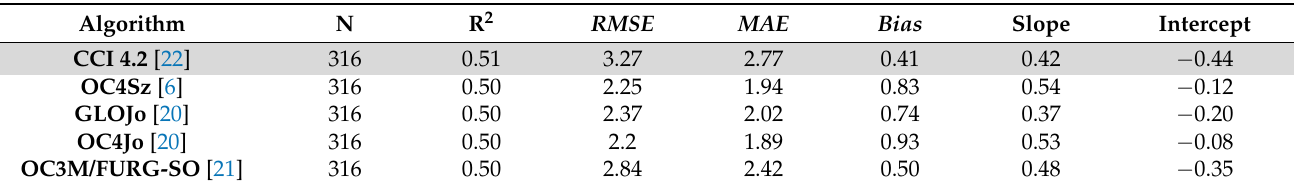
Figure 2. Match-ups’ locations and performance of the CCI 4.2 product. ( a ) Locations of the match- ups used in this work. The colour code indicates whether the in-situ Chl- a measurement was obtained from GOAL-FURG (blue) or extracted from the database published by [30] (black). ( b ) Comparison of the CCI 4.2. satellite Chl- a and in-situ Chl- a . Note that the scale is logarithmized (log 10 ). The green line represents the 1:1 line (ideal correspondence). ( c ) Comparison between the performance of all the Chl- a products and algorithms used in this study. The thick black line corresponds to an ideal performance for each presented metric (% wins = 100%, MAE = 1, bias = 1 and R 2 = 1). Thus, the closer to this line an algorithm is, the better its performance. Note that the MAE , bias and R 2 cannot be negative. In the MAE and bias cases, this is due to the use of log 10 Chl- a values when calculating these metrics. As such, both MAE = 1 and bias = 1 correspond to an actual value of 0 (no bias and no MAE ). Table 3. Comparison of the performance between the CCI 4.2 satellite Chl- a product and other empirical regional algorithms for the match-up